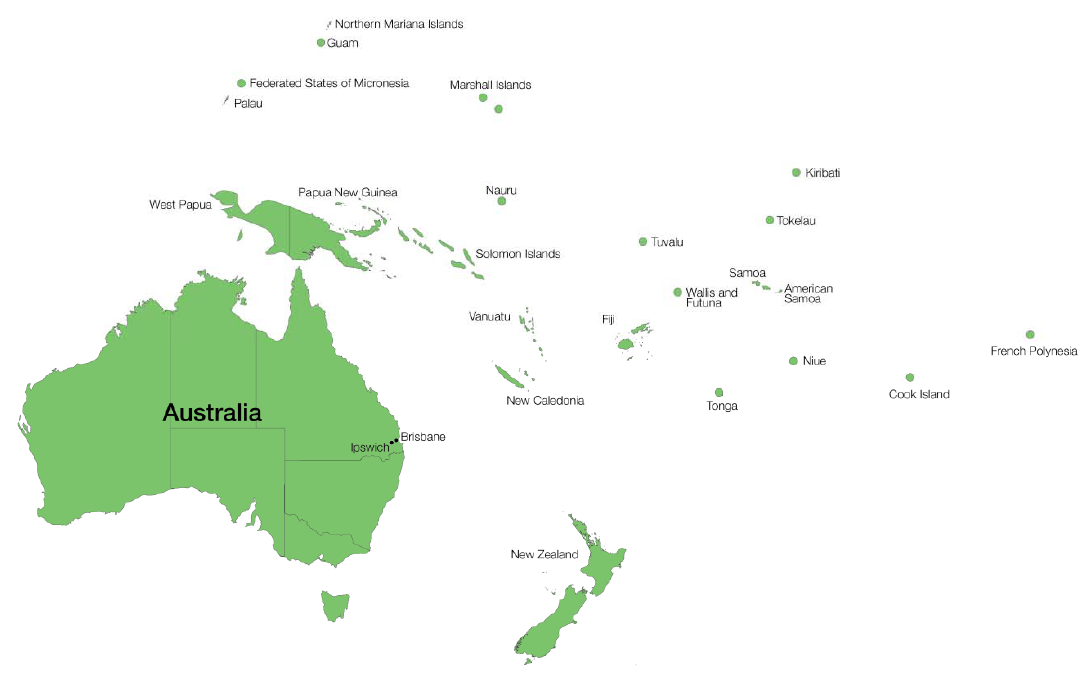
Figure 2. Location of the Islands present in Oceania and the Pacific referred to in this review.